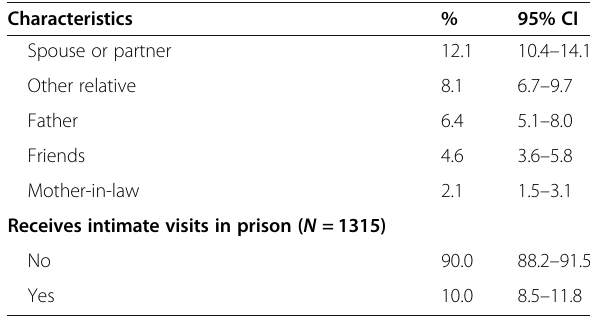
Table 1 Sociodemographic and prison characteristics of women incarcerated in Brazil, 2018 (Continued)